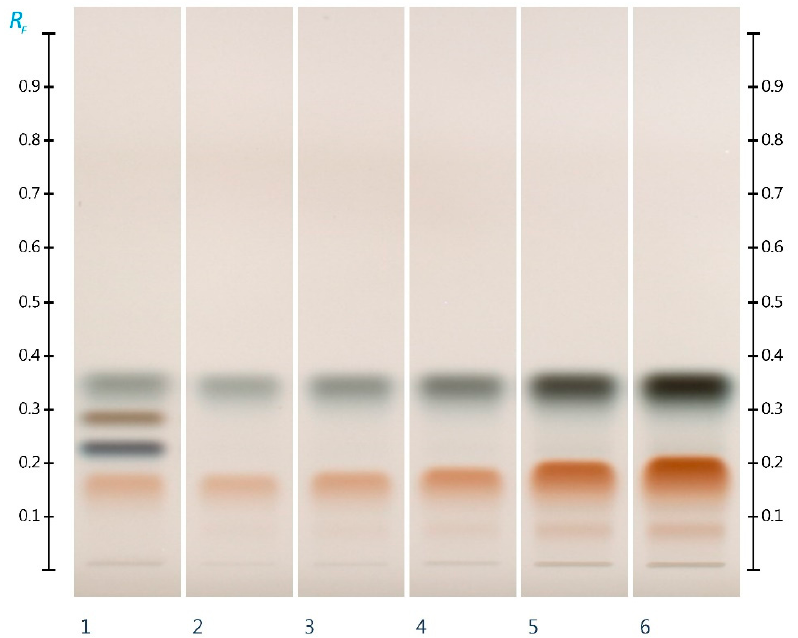
Figure 3. HPTLC images taken at white light after derivatization with aniline–diphenylamine–phosphoric acid reagent; Track 1—standards (fructose, maltose, sucrose, and glucose in increasing Rf